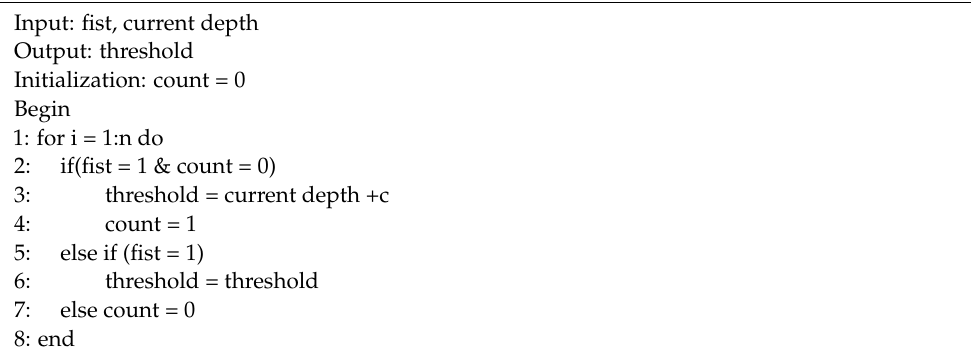
Algorithm 1 . Pseudocode for the algorithm to determine push gesture